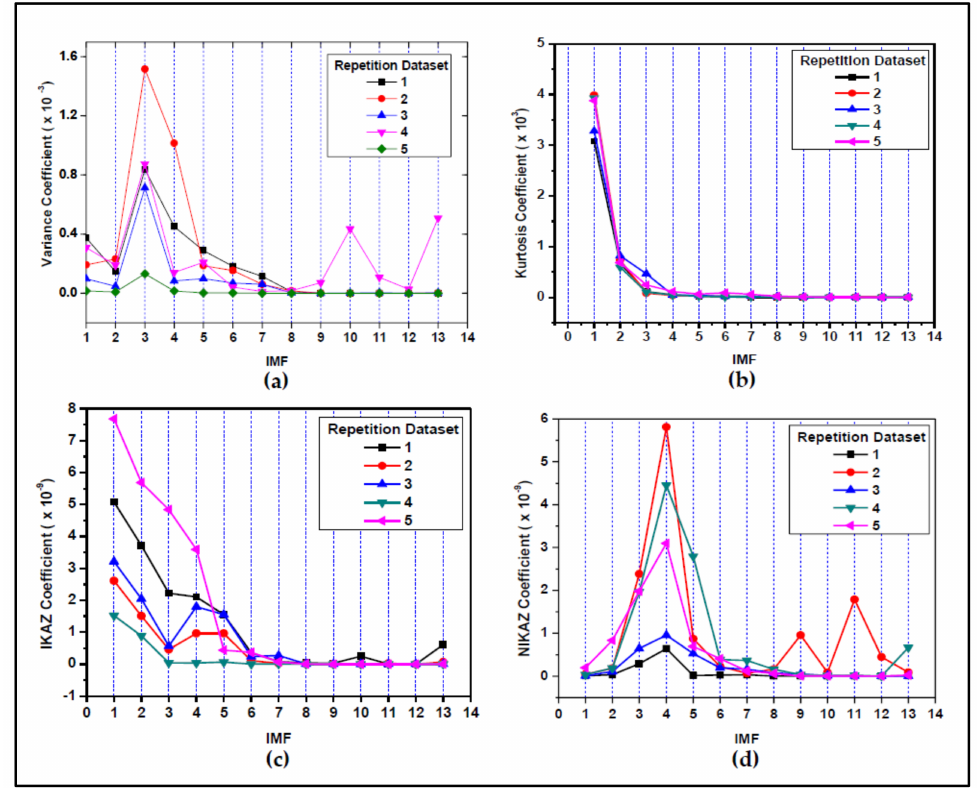
Figure 11. The curve for no-leak IMFs with 4 bar pressurised pipe: ( a ) Variance, ( b ) Kurtosis, ( c ) IKAZ, ( d )